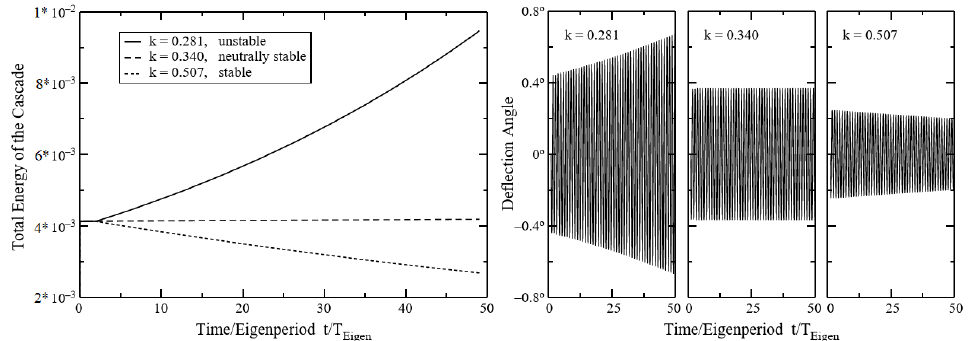
Figure 6. Total energy of a cascade and deflection angle at three different conditions: stable mode, limit cycle behaviour and unstable mode, from Sadeghi